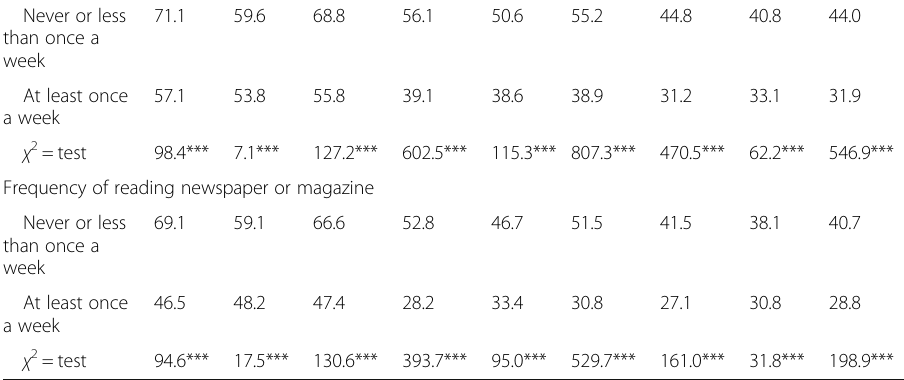
Table 2 Percent distribution of women who agreed that a husband is justified for beating his wife by marital status according to individual characteristics, 2003, 2008, and 2013 Nigeria Demographic and Health Survey